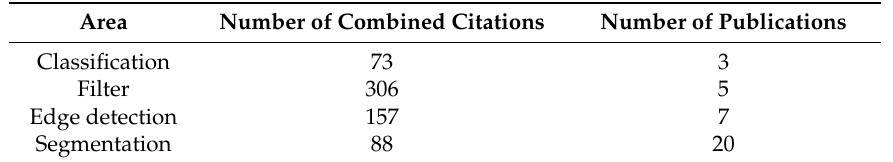
Figure 4. Pie chart showing the distribution of received combined citations in the areas of focus for this review paper. Table 3. Relation between number of combined citations and number of publications per research area.